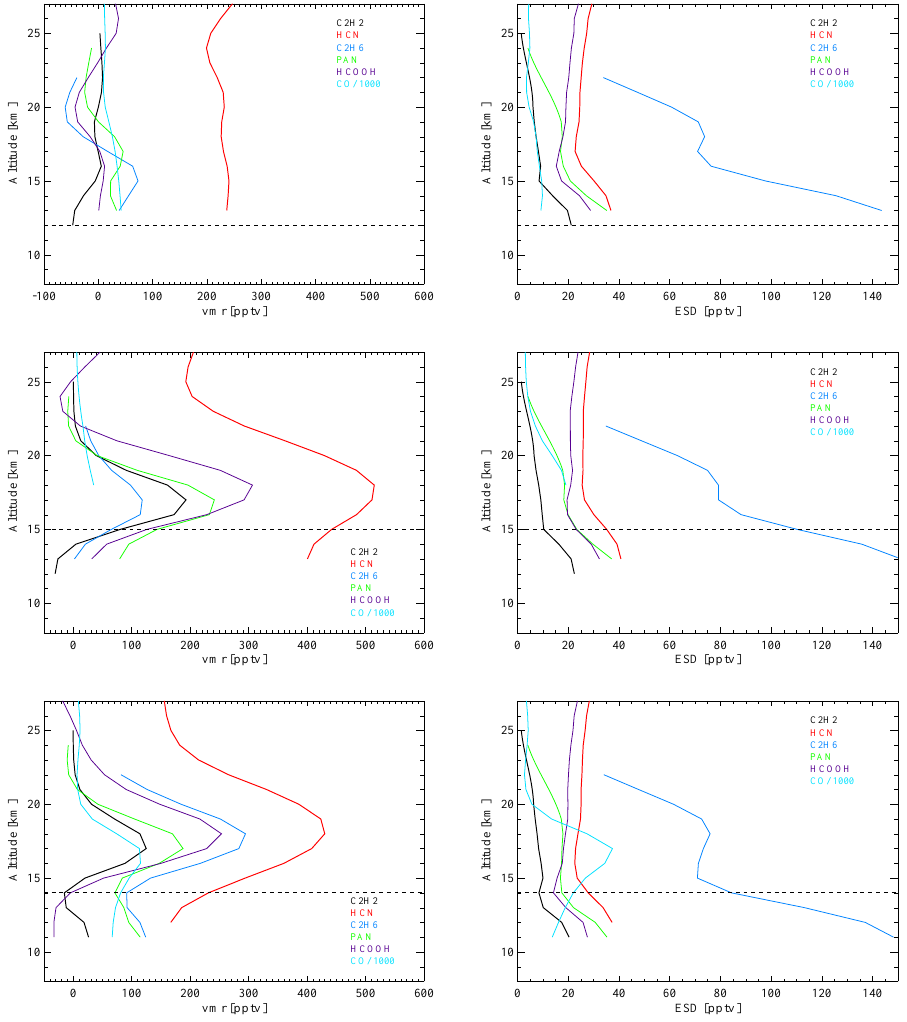
Fig. 1. Upper row: (left) VMR profiles of C 2 H 2 , HCN, C 2 H 6 , PAN, HCOOH and CO, measured by MIPAS on 7 February 2009, in an unpolluted atmosphere over the central South Pacific. CO amounts are in ppbv and scaled down by a factor of 1000. (right) Corresponding estimated retrieval error. Dashed line indicates the altitude of the thermal tropopause. Middle and lower row: same as upper row, but for MIPAS measurements on 17 February 2009, inside the Australian bushfire plume. The measurements were made at 38.9 ◦ S, 151.7 ◦ W